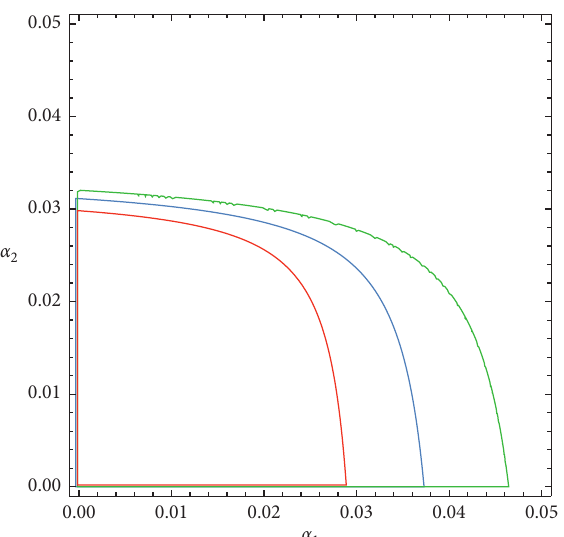
Figure 1: Stable regions of system (17) with different values of μ